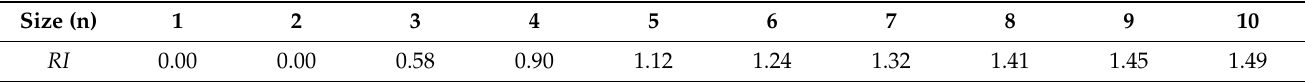
Table 4. The random consistency index ( RI